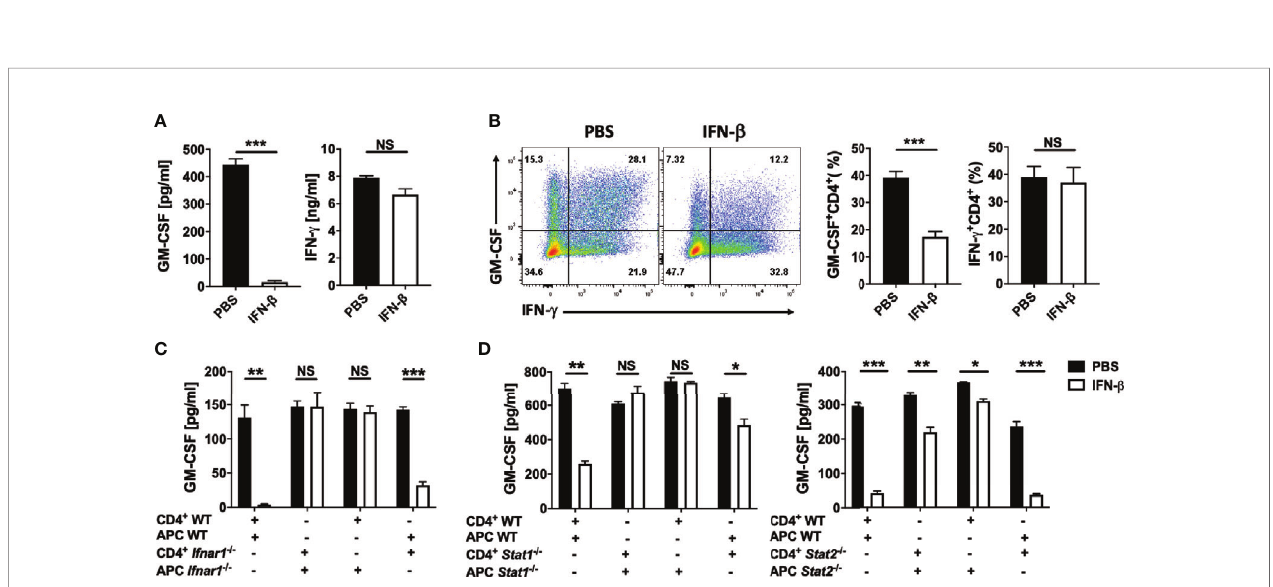
FIGURE 2 | rIFN- b acts on antigen presenting cells to suppress GM-CSF production by Th cells. Splenic naïve (CD62 + CD44 - CD25 - ) CD4 + T cells were co-cultured with T cell-depleted splenocytes (APCs) and activated for 72 h with anti-CD3/28 Abs, with or without addition of rIFN- b (1000 IU/ml) into culturing media. (A) GM- CSF and IFN- g concentrations in cell culture supernatants measured by ELISA after three days of culturing. (B) Representative fl ow cytometry dot plots showing GM- CSF and IFN- g expression by CD4 + T cells, and proportions (%) of GM-CSF + and IFN- g + CD4 + T cells. (C) WT or Ifnar1 -/- splenic naïve CD4 + T cells were co- cultured with WT or Ifnar1 -/- APCs and activated for 72 h with anti-CD3/28 Abs, with or without addition of rIFN- b into culturing media. GM-CSF concentrations in cell culture supernatants were measured by ELISA after three days of culturing. (D) WT, Stat1 -/- or Stat2 -/- splenic naïve CD4 + T cells and APCs were co-cultured, activated with anti-CD3/28 Abs, with or without addition of rIFN- b into culturing media. GM-CSF concentrations in cell culture supernatants were measured by ELISA after 72 h of culturing. These experiments were conducted three times with similar outcomes. Data shown are mean ± SEM. P-values were calculated using unpaired Student ’ s t -test; *p < 0.05, **p < 0.01, ***p < 0.001, NS, not signi fi